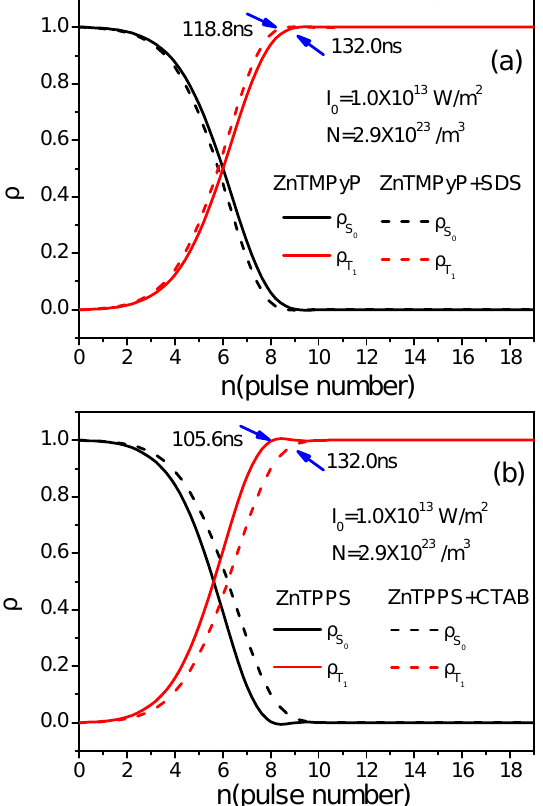
Figure 5. Population dynamics ρ S and ρ T at L = 0 for ZnTMPyP and ZnTPPS in aqueous so- 1 0 lutions and their porphyrin J-aggregates with micelles of SDS and CTAB. ( a ) ZnTMPyP in aque- ous solutions and in micelles of SDS. ( b ) ZnTPPS in aqueous solutions and in micelles of CTAB. I 0 = 1.0 × 10 13 W/m 2 , N = 2.9 × 10 23 /m 3 .